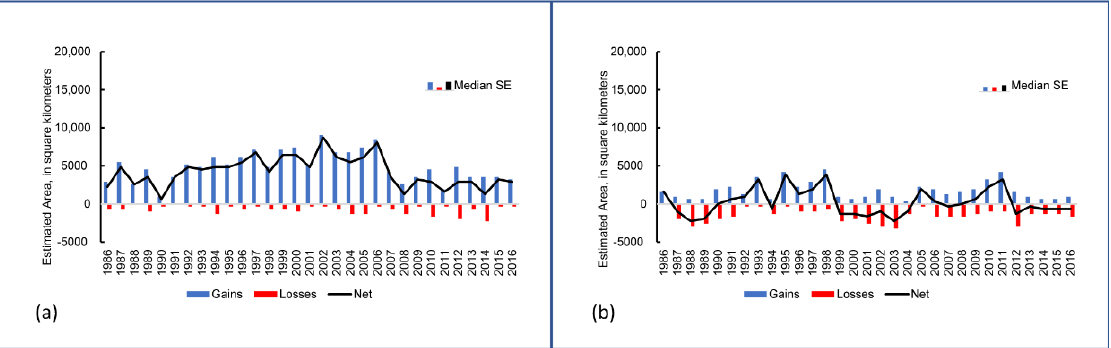
Figure 6. Estimated annual area of major sources of change to developed land cover, 1985 – 2016, with 1986 “change year” starting on 1 July 1985.